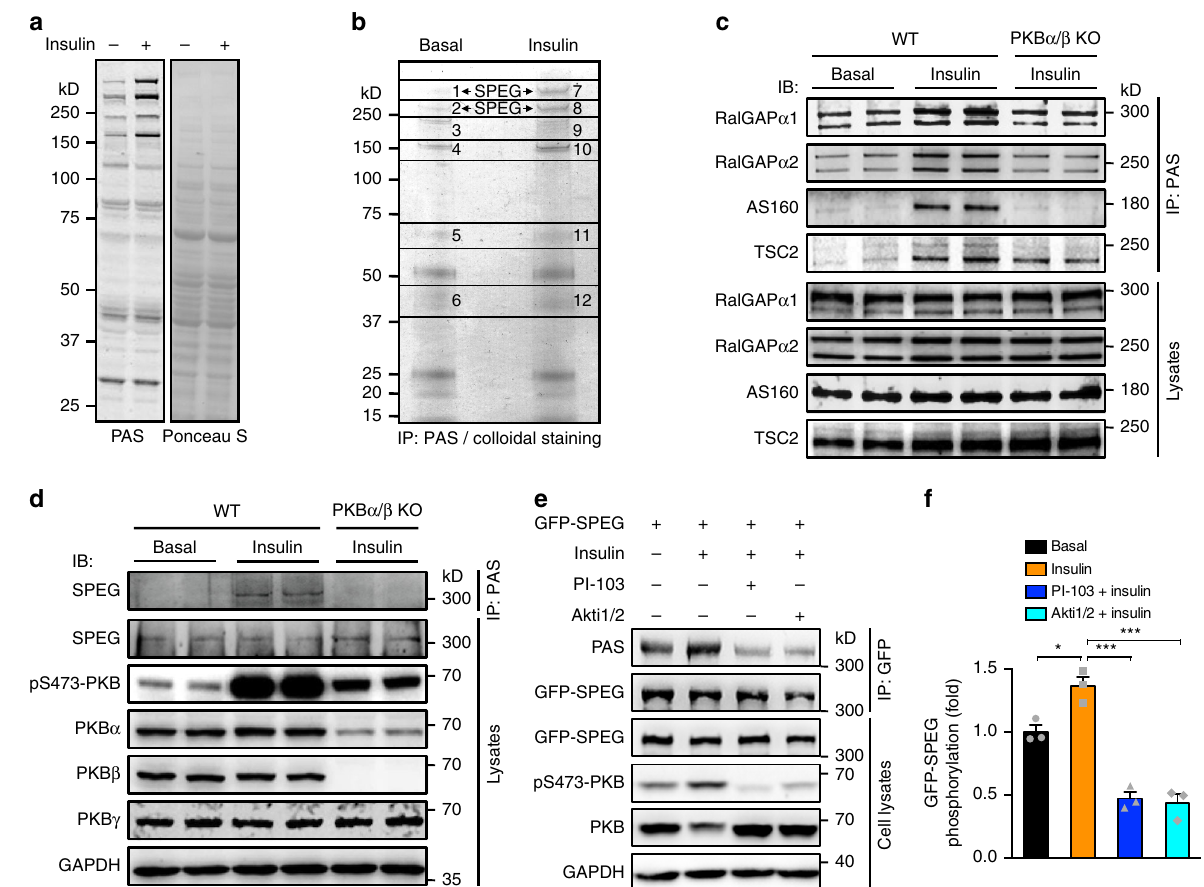
Fig. 2 Identi fi cation of SPEG as a phosphoprotein regulated by the insulin – PKB pathway. a PAS-reactive protein phosphorylation in lysates of hearts from mice that were intraperitoneally injected with or without insulin. b Immunoprecipitation of potential PKB substrates from lysates of mouse hearts stimulated with or without insulin using the PAS antibody. Immunoprecipitated proteins were identi fi ed via mass-spectrometry and summarized in Supplementary Data 1. c Immunoprecipitation of known PKB substrates from lysates of WT and PKB α / β KO (PKB α f/f ; α MHC-Cre;PKB β − / − ) mouse hearts stimulated with or without insulin using the PAS antibody. RalGAP α 1, RalGAP α 2, AS160, and TSC2 in the PAS immunoprecipitates were detected with the corresponding antibodies via western blot. d Immunoprecipitation of phosphorylated SPEG from lysates of WT and PKB α / β KO (PKB α f/f ; α MHC-Cre; PKB β − / − ) mouse hearts stimulated with or without insulin using the PAS antibody. SPEG in the PAS immunoprecipitates and heart lysates was detected via western blot. e , f . Full-length SPEG was tagged with GFP and expressed in HEK293 cells that were treated with the PI 3-kinase inhibitor PI-103 and PKB inhibitor Akti1/2 in the presence or absence of insulin. PAS-reactive phosphorylation of SPEG was detected on immunoprecipitated SPEG using the PAS antibody. e representative blots. f Quantitation of PAS-reactive phosphorylation of GFP-SPEG. n = 3. The data are given as the mean ± SEM. Statistical analysis was carried out using one-way ANOVA. One-asterisk indicates p < 0.05, and three-asterisk indicates p < 0.001. Source data are provided as a Source Data fi